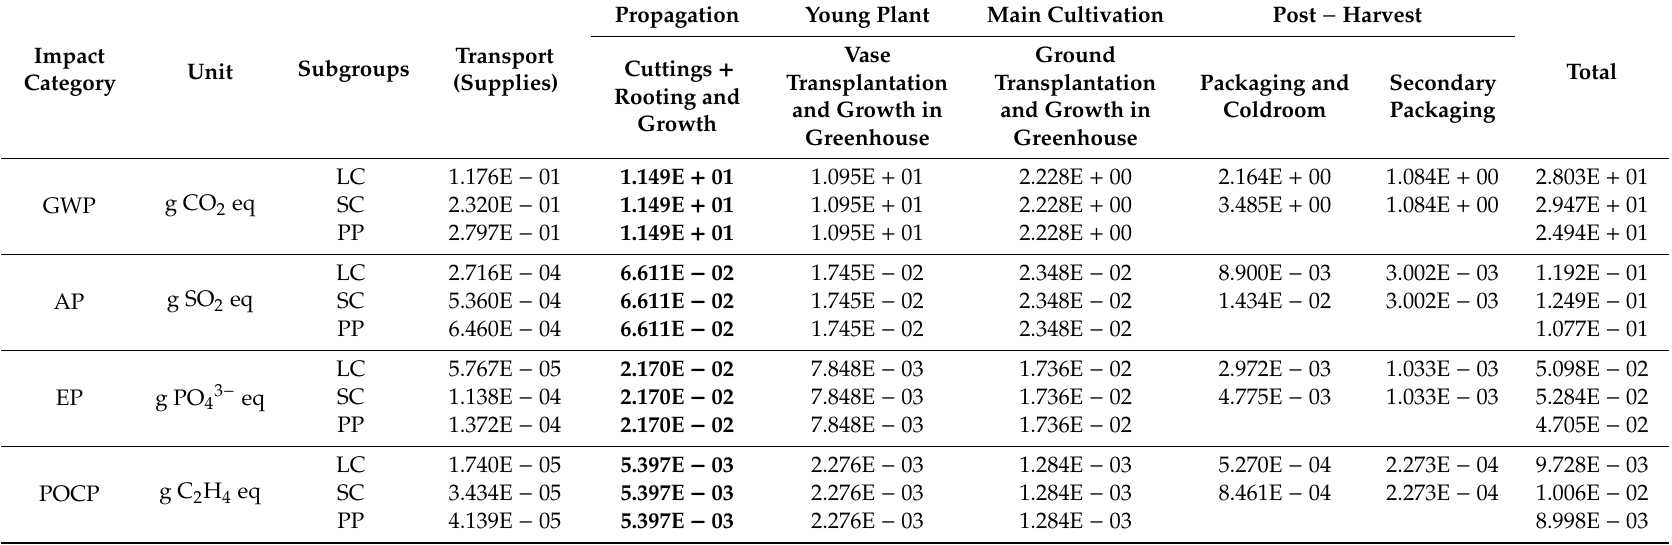
Top contributions are highlighted in